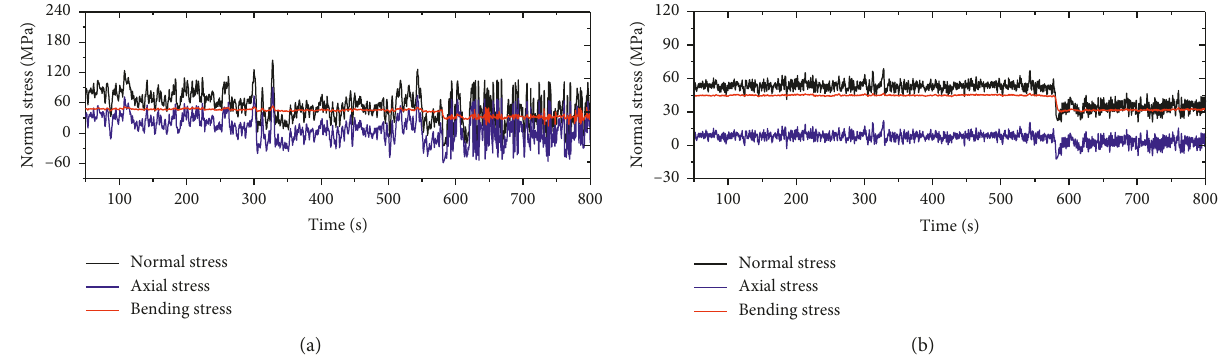
Figure 11: Axial stress, bending stress, and normal stress for two kinds of the pull rods. (a) Type A. (b) Type B. Table 3: Statistical results of the axial stress, bending stress, and total stress.